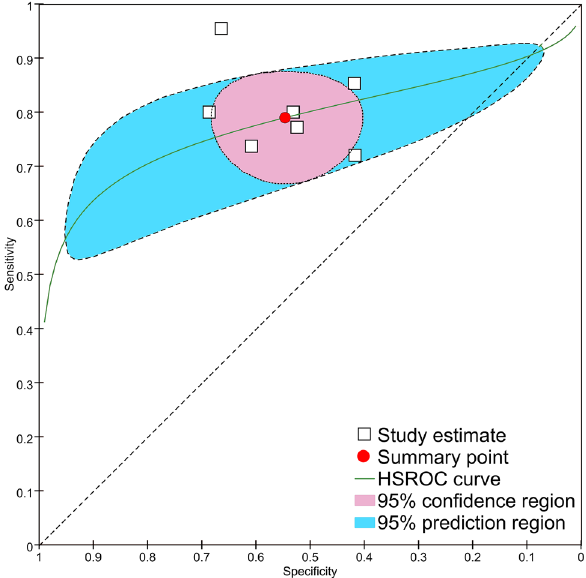
Figure 2. Summary of the receiver operating characteristic (SROC) plot of the spinal instability neoplastic score (SINS). The pooled sensitivity, specificity, and SROC curve for the prediction of vertebral compression fracture using the SINS are depicted. The area under the SROC curve (AUC) was 0.776. If the cut-off value was 7, the pooled sensitivity was 0.790 (95% confidence interval [CI] 0.723–0.843) and the specificity was 0.546 (95% CI 0.462–0.627) as indicated by the red point. The 95% confidence region is shown in pink. This figure was drown using Review Manager version